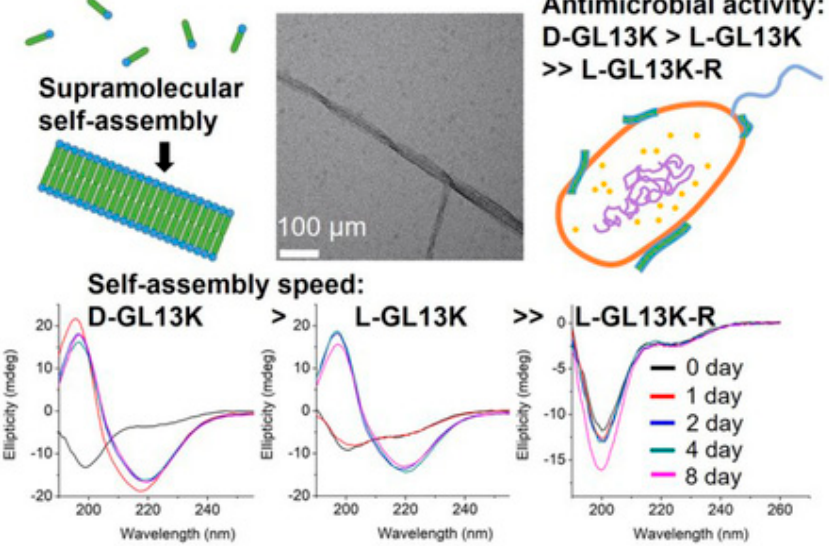
Figure 6. (Top) L-GL13K nanoribbon self-assembly schematic, SEM image of GL13K nanoribbon, and cartoon of bacterial membrane interaction (from left to right). (Bottom) Circular dichroism spectra of D-, L-, and scrambled GL13K analogues as a function of time. Reproduced from [118] with permission from The Royal Society of Chemistry.